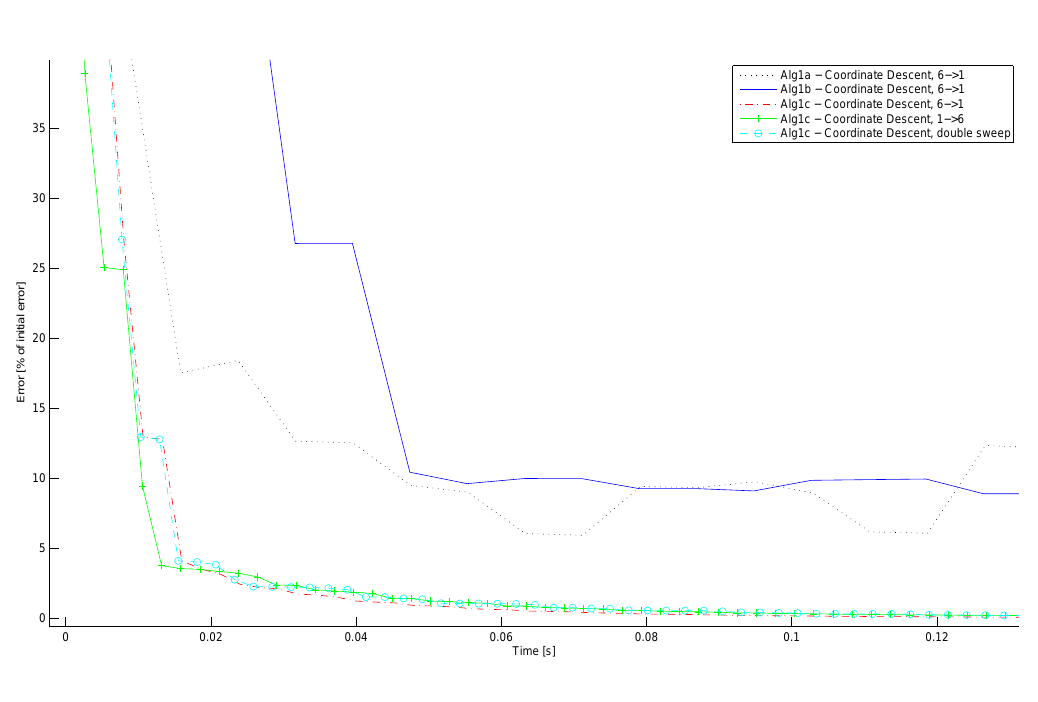
Figure 2: Convergence of Coordinate Cyclic Descent Algorithms that move one joint at the time. Initial condi- tions is set far from a solution.